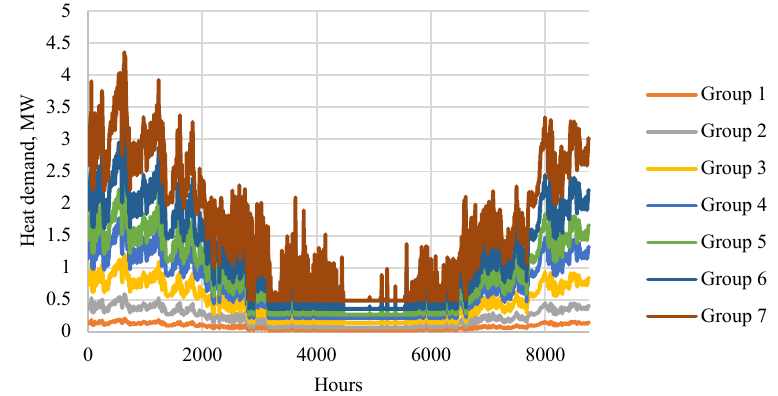
Fig. 1. Heat demand profiles for each